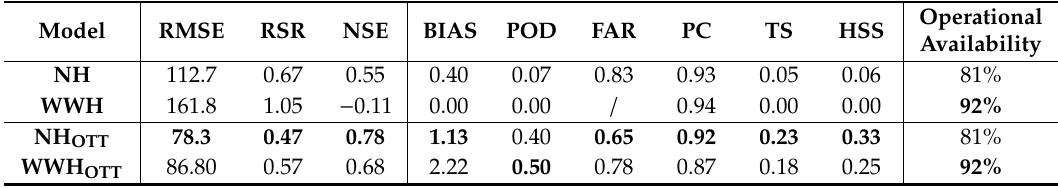
Table A3. Continuous and categorical indices and operational availability for original and optimized forecasts at Bossey Bangou. Best performance is shown in bold.